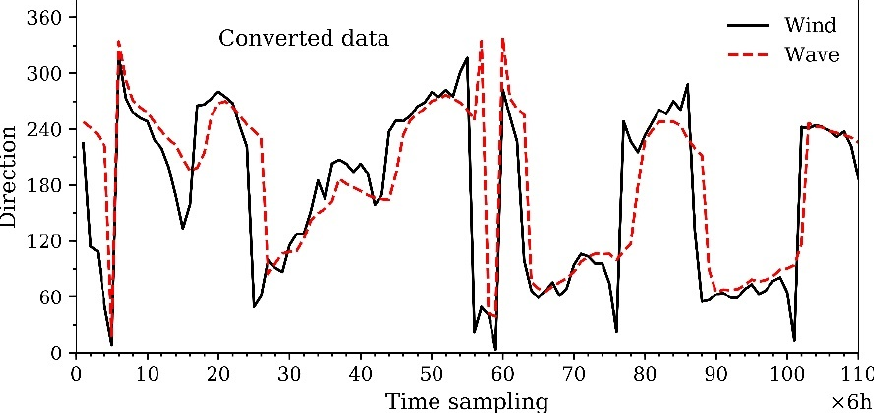
Figure 1. Comparison between converted wave direction and wind direction in the Yellow Sea.